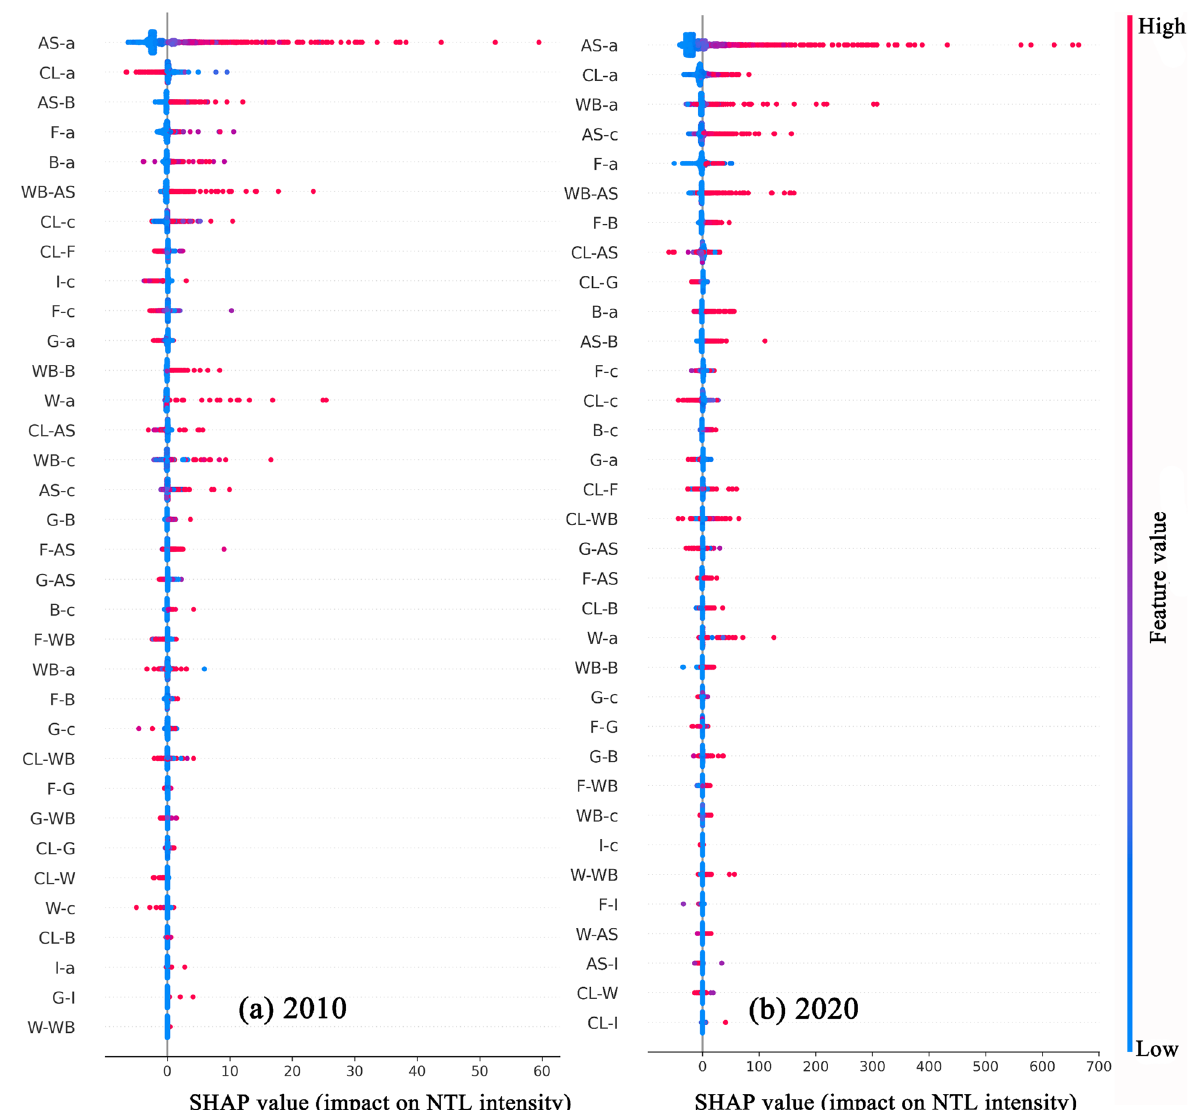
Fig. 5 SHAP summary plots of land cover metrics from model 6 in ( a ) 2010 and ( b )